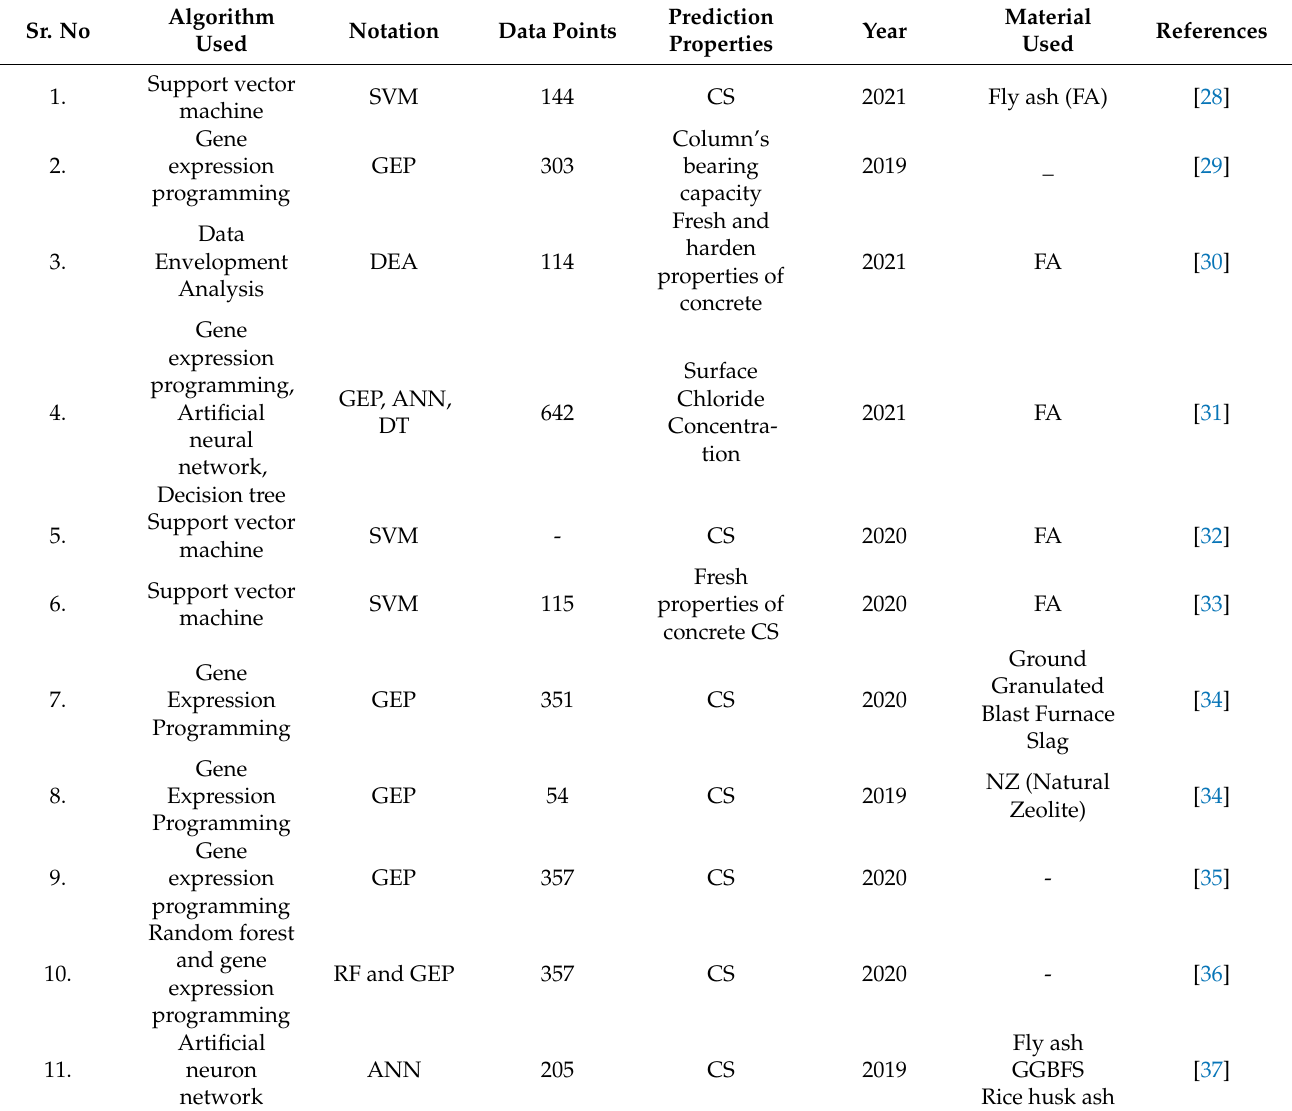
Table 1. Various predicted properties with the application of ML